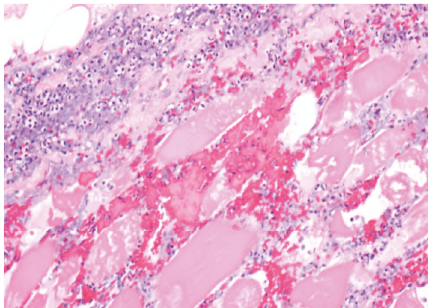
Figure 3: Histological section of the muscle biopsy, showing intense neutrophilic infiltration with evidence of skeletal muscle edema and necrosis.